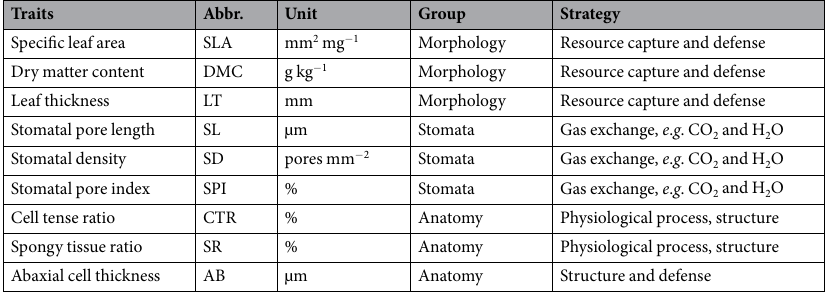
Table 1. The nine measured traits and their